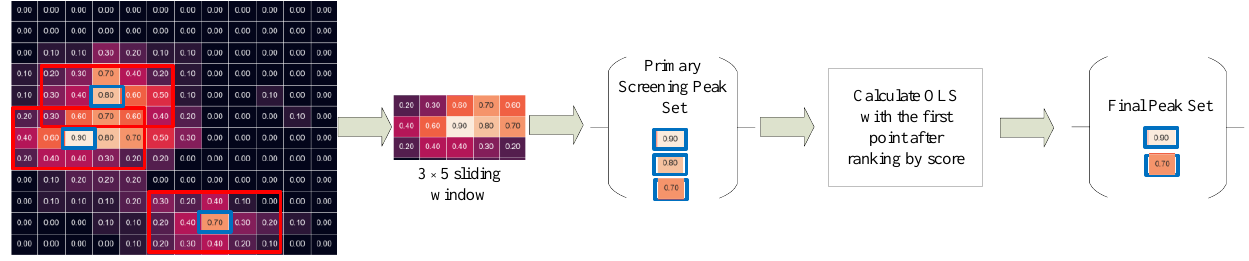
Figure 7. OLS target-location detection flow chart.